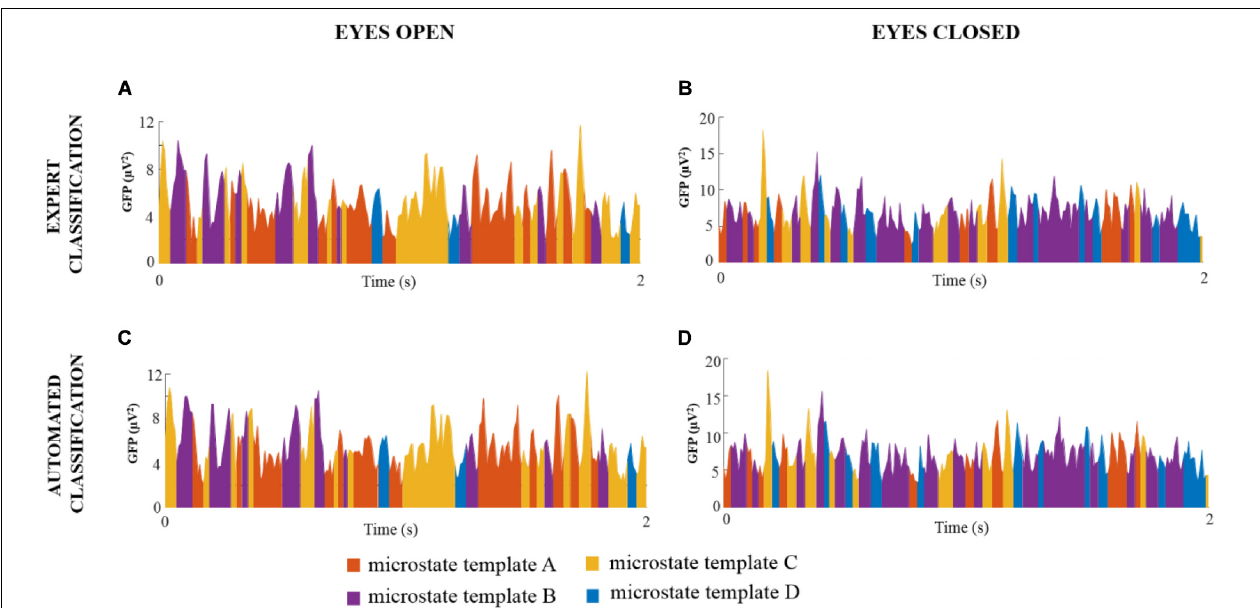
FIGURE 3 | Examples of sequences of global microstate templates for a representative EEG dataset (subject 1 for each condition) denoised after expert and automated classification of the ICs. The X -axis represents the time (s) and the Y- axis represents the GFP values of the EEG signal. Each GFP sample is assigned to one global microstate template, thus resulting in a sequence of four different colors: orange indicates the global microstate template A, purple indicates the global microstate template B, yellow indicates the global microstate template C, and blue indicates the global microstate template D.